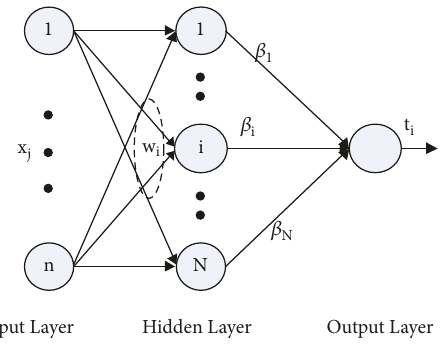
Figure 2: An illustrative network structure of extreme learning